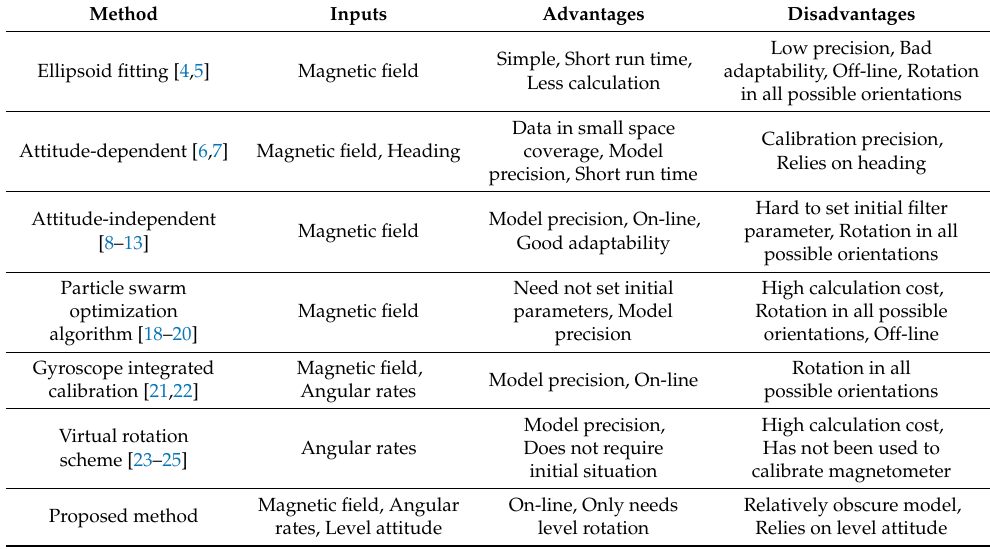
Table 1. Comparison of magnetometer calibration methods.